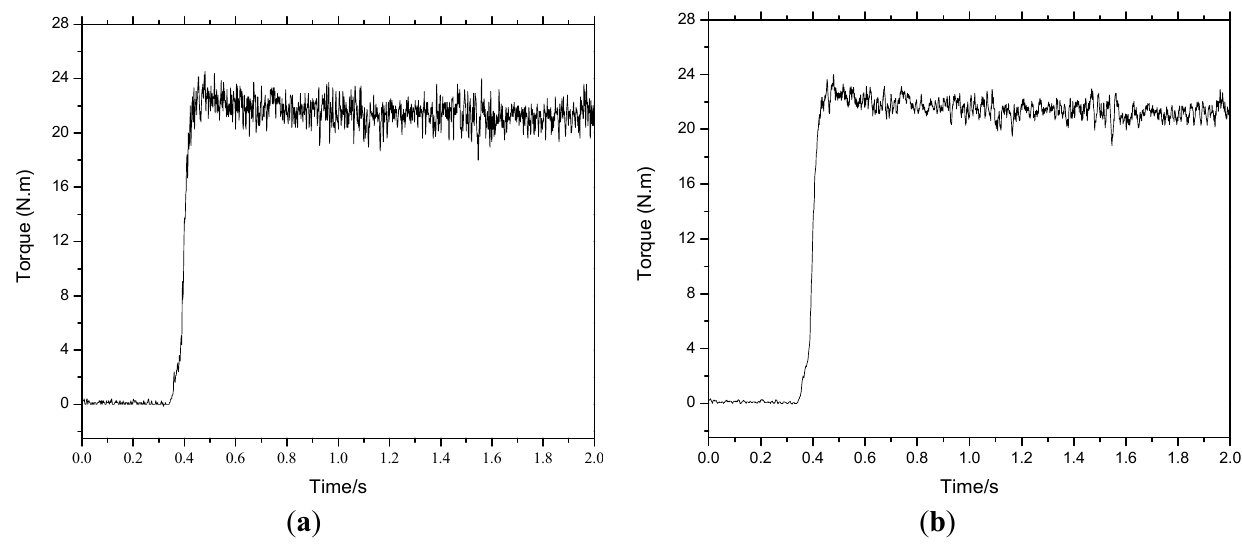
Figure 9. Time response of the output torque when using different controller when = 20 N. m and n = 1000 rpm: ( a ) conventional PI controller; and ( b ) proposed sliding T L mode controller.